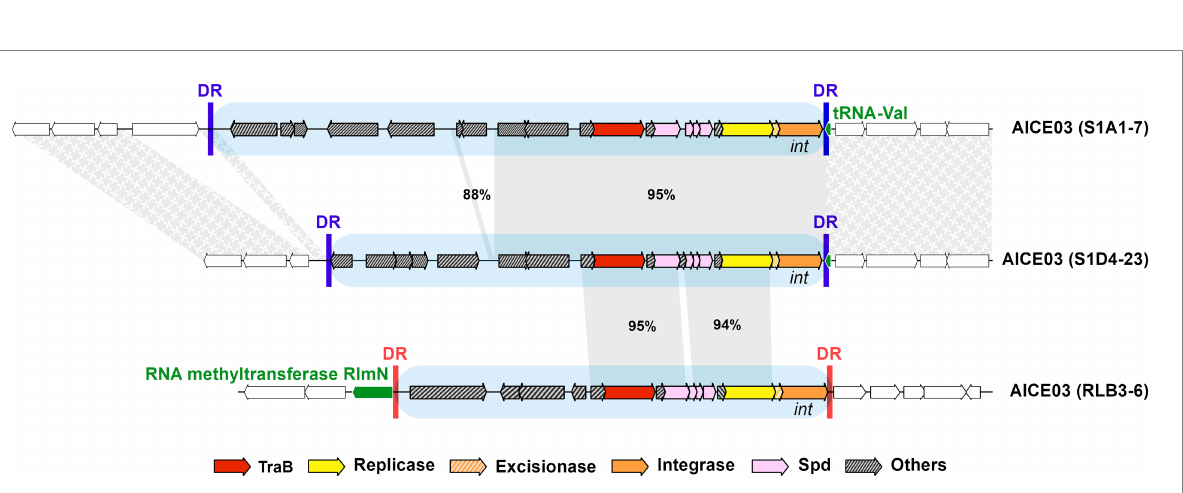
FIGURE 3 Intra-familial diversity in an AICE. An illustration of the gene content diversity of elements belonging to the same family (i.e., sharing the same highly identical TraB proteins), as well as the integration site specificity engendered by different integrases. These three AICEs belong to the same family (family 03 highlighted by blue boxes) but all share different cargo genes. While AICE03 in strains S1A1-7 and S1D4-23 share the same integrase and are inserted in the same tRNA-Val gene, AICE03 in RLB3-6 possesses a divergent integrase and excisionase and is found inserted in rlmN , a 23S methyltransferase encoding gene. The specific direct repeats generated by the integrase upon the element integration are represented by vertical bars and are different depending on the integrase and their target gene. Direct repeats (DR) of AICE03 in strains S1A1-7 and S1D4-23 are identical (blue), while those of strains RLB3-6 are different in size and sequence (red). The conserved regions between the AICEs are indicated by grey bands with percentage nucleotide identity indicated. Other examples of intra-familial AICE diversity are depicted in Supplementary Figure S2 and S3. Synteny on either side of the insertion site is indicated by textured grey